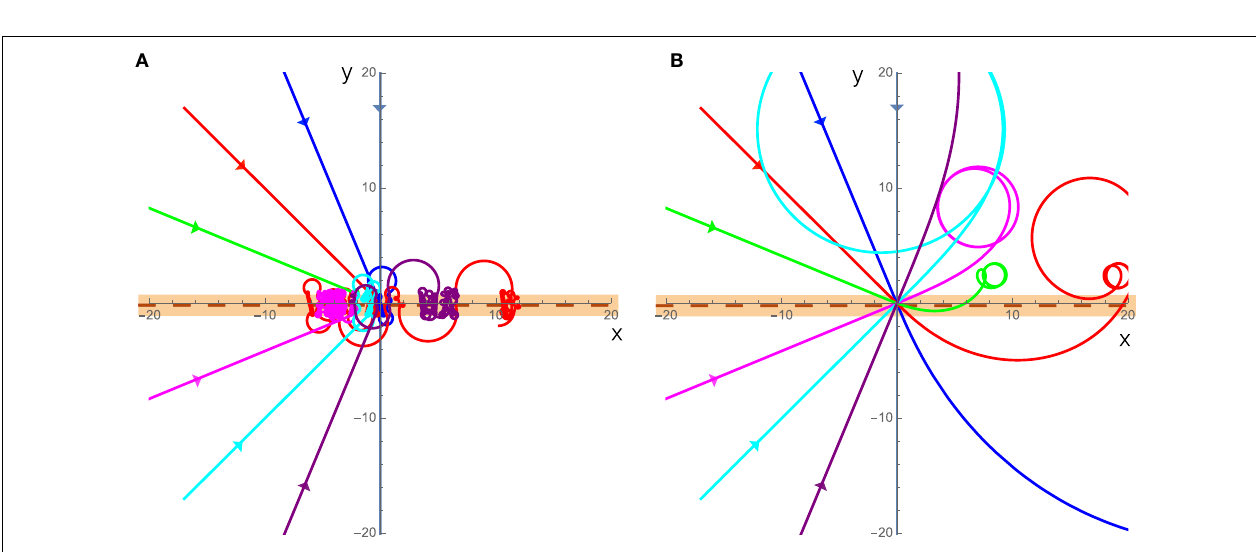
FIGURE 6 | (A) Trajectories for the C = 0 case with low velocities. v 1 = 0.001 and v 2 = 0.002, the incident trajectories are the straight lines coming from the left. (B) Same as (A) but for the high velocity case where v 1 = 5 and v 2 = 10. The cluster is in contact with the interface while the trajectory is shown in the orange band.